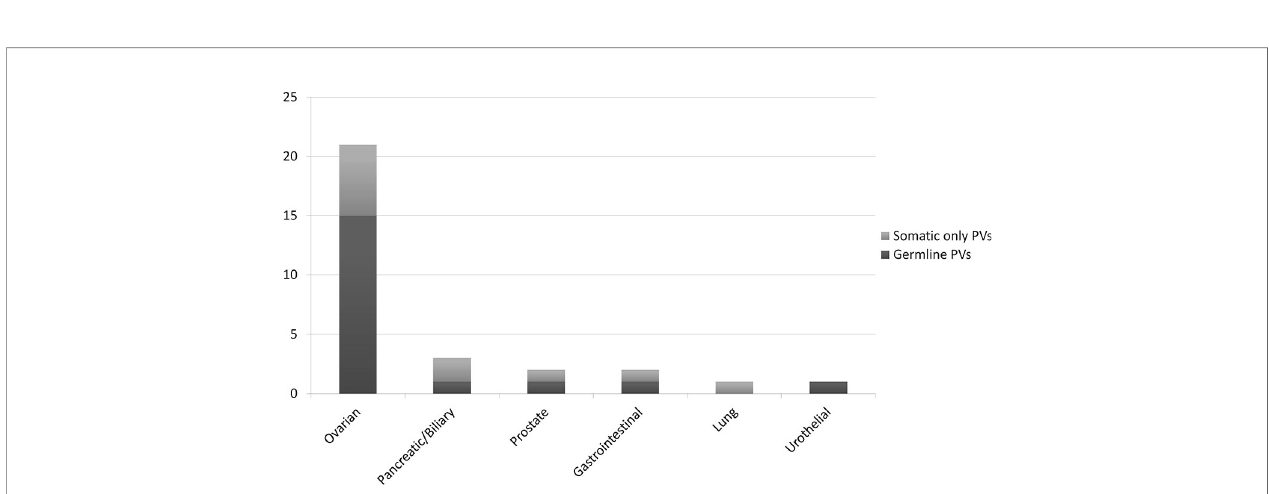
FIGURE 5 | Ratio of somatic only vs. germline BRCA pathogenic/likely pathogenic variants (PVs), according to the primary tumour type, in 30 patients who underwent both tumour and germline testing.